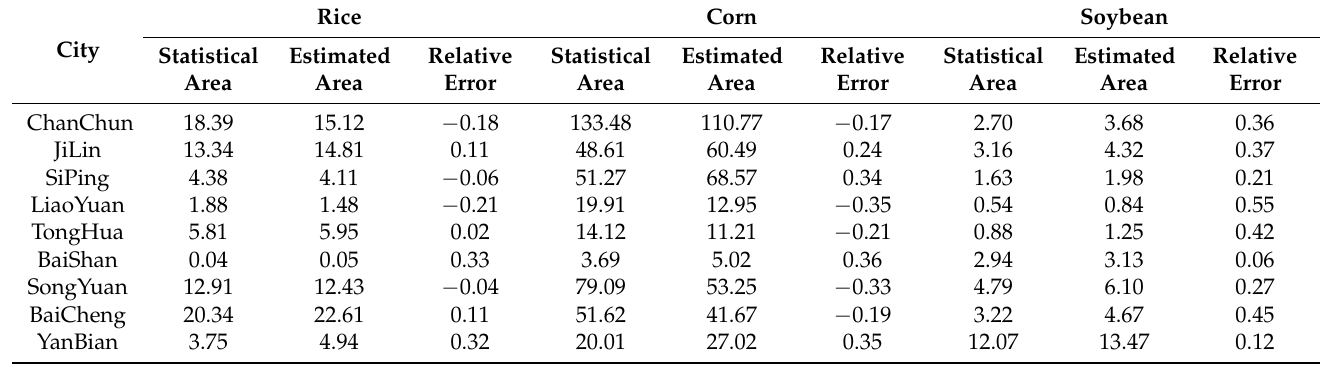
Table 4. Relative error of crop extraction results in 2020 (10 4 ha). Rice Corn Soybean City Statistical